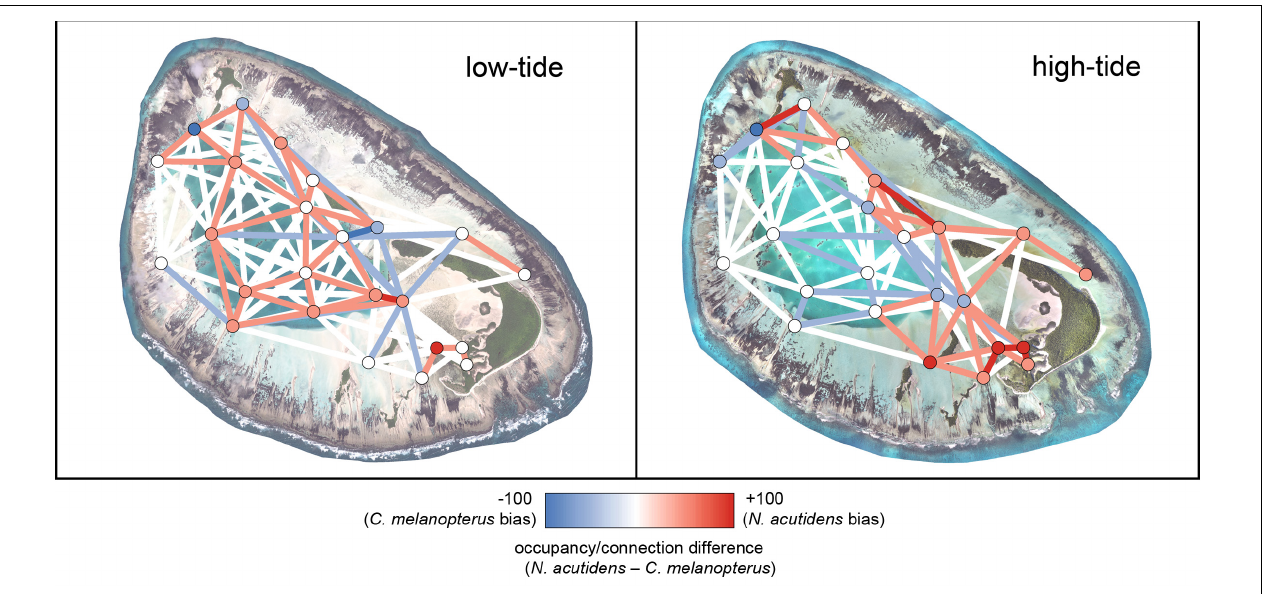
FIGURE 5 | Relative 1-hour difference networks showing how space use differs between sicklefin lemon shark Negaprion acutidens and blacktip reef shark Carcharhinus melanopterus at low ( < 1.4 m) and high ( > 1.4 m) tidal states. Each difference has been calculated as the metrics of the sicklefin lemon shark network minus those for the blacktip reef shark network; red shows a stronger sicklefin lemon shark bias, blue shows a stronger blacktip reef shark bias. The low-tide satellite image of St Joseph was acquired from LAND INFO Worldwide Mapping, LLC (Denver CO, United States), and includes material Copyright DigitalGlobe (Longmont, Colorado). The high-tide image of St Joseph was provided courtesy and Copyright of Drone Adventures for the Save Our Seas Foundation. The maps were produced using ArcGIS (ESRI Inc., CA, United